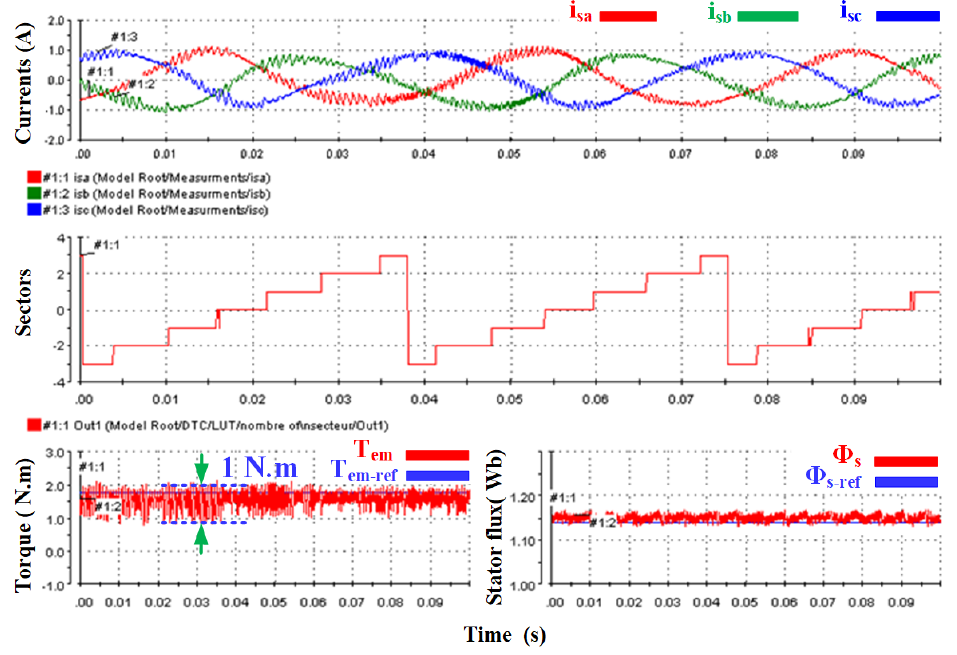
Figure 21. Experimental results of the classical DTC